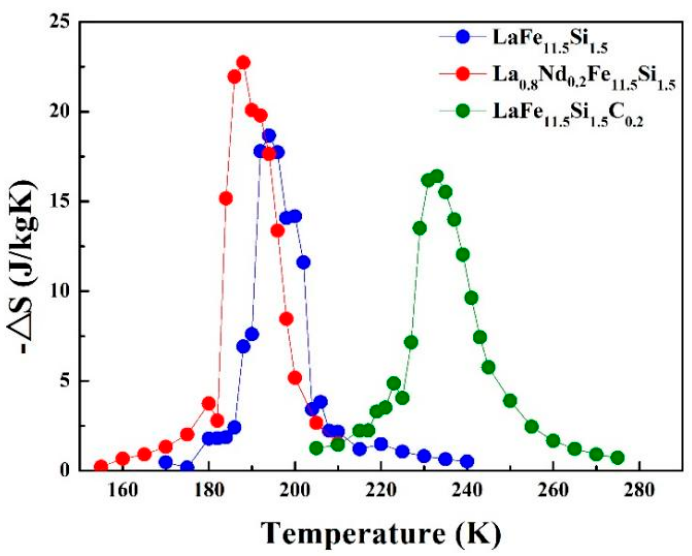
Figure 5. Magnetic entropy change in LaFe 11.5 Si 1.5 , La 0.8 Nd 0.2 Fe 11.5 Si 1.5 , and LaFe 11.5 Si 1.5 C 0.2 as a function of temperature for an external magnetic field change of 0–3 T.